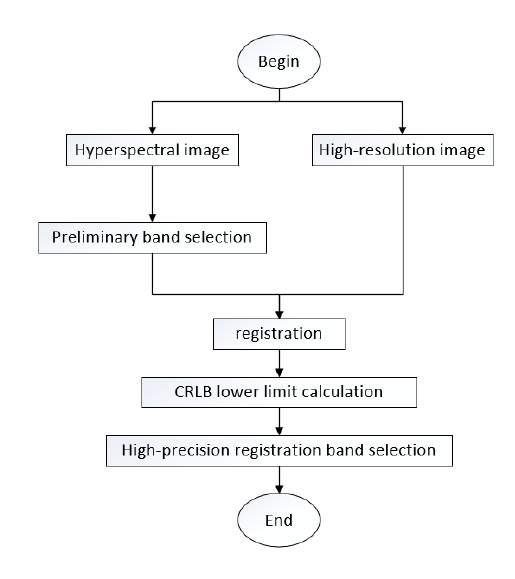
Figure1: high-precision registration band selection algorithm flow